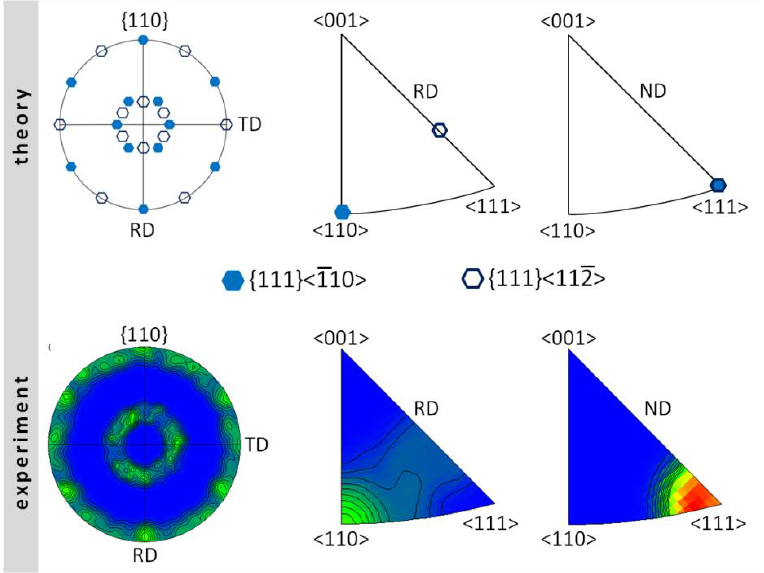
Figure 8. Theoretical and experimental pole figures (PFs) and inverse pole figures (IPFs) for the FeAl alloy after hot rolling: RD – rolling direction, TD – transverse direction, ND – normal direction.